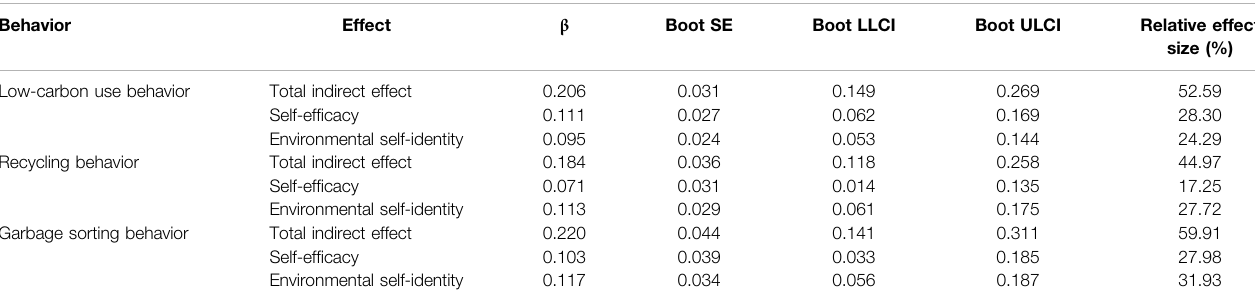
TABLE 5 | The mediating effect of self-ef fi cacy and environmental